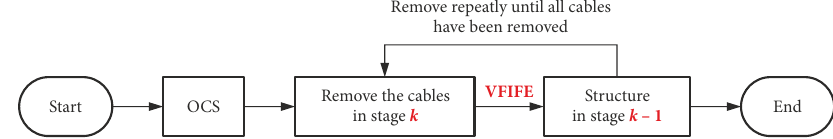
1VFIFE Structure Remove the cables in stage k – in stage k Figure 6. Flow chart of the novel backward algorithm